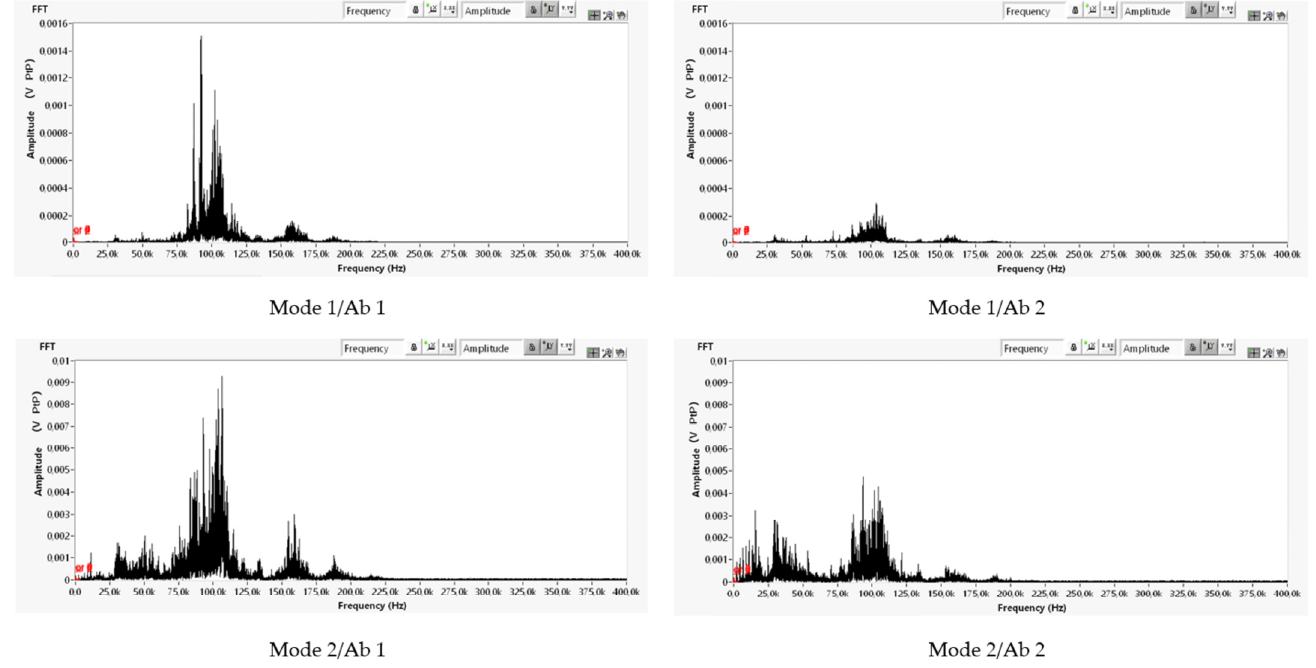
Figure 9. FFT analysis of acoustic emission.